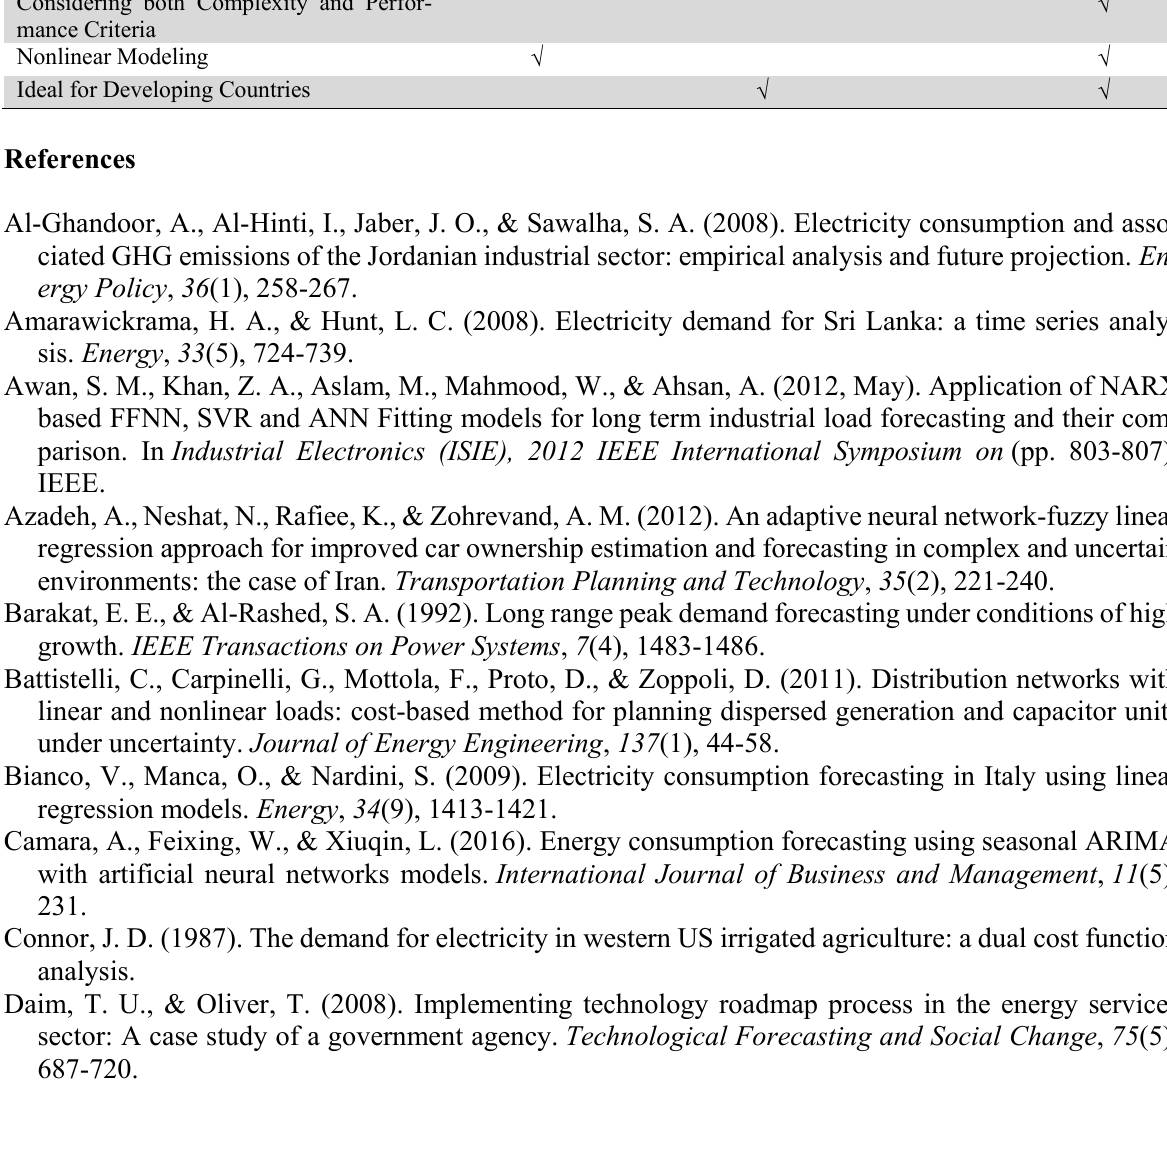
The features of proposed NARIMAX model versus existing models Feature Data Transformation, Pre-Processing and Post-Processing Disaggregated (Sectoral)